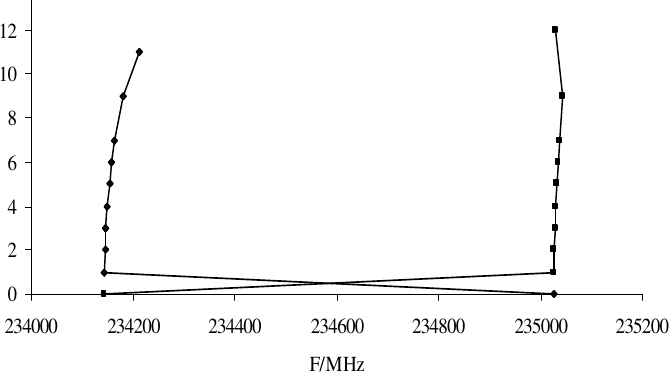
Figure 3 . Fortrat diagram of PF